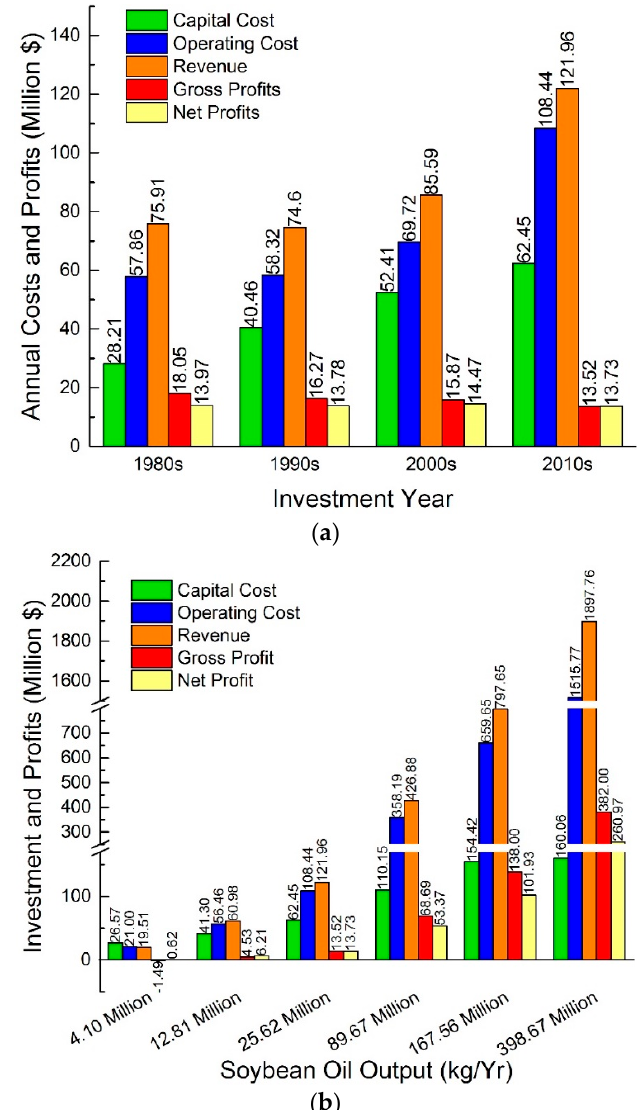
Figure 8. Capital investment, gross and net profits for soybean oil extruding-expelling. ( a ) 1980–2015 data; ( b ) Various scales of oil production (2010s input only).